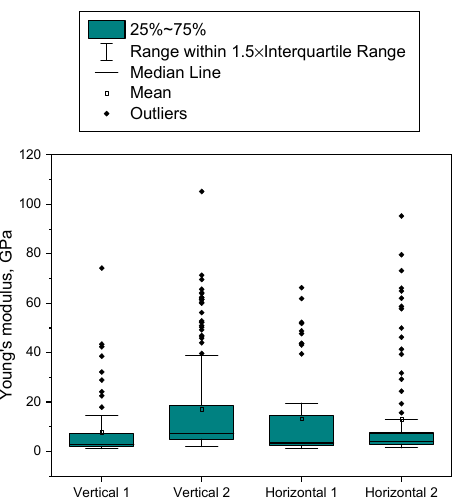
Figure 4. Statistical analysis (box plot) of Young’s modulus of four samples where vertical and horizontal corresponds to the mode of printing (depositing particles by the printer).